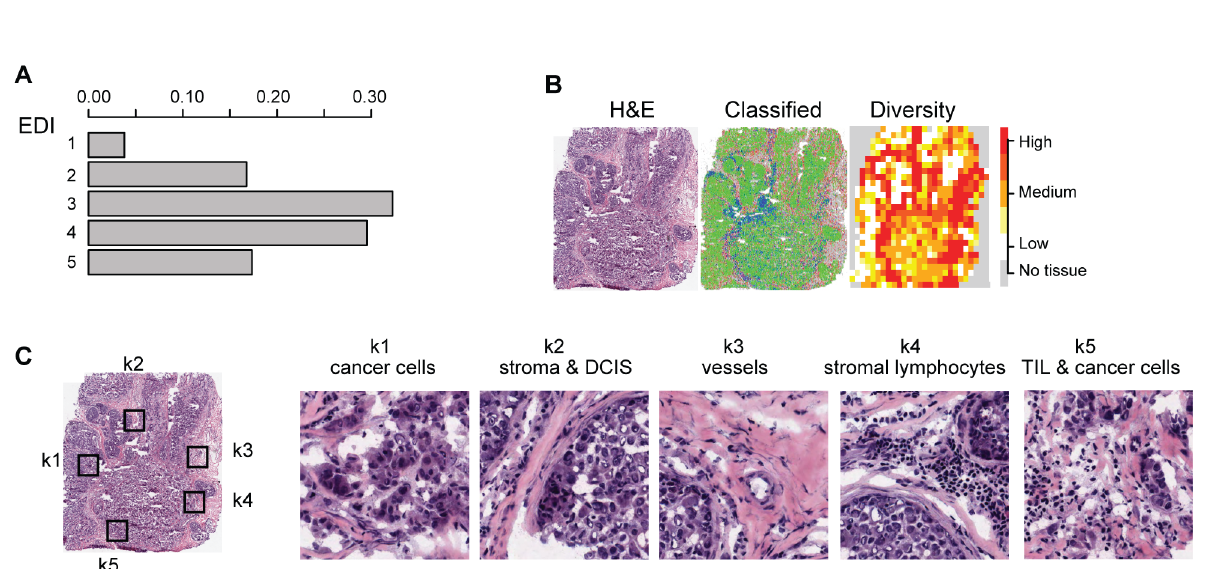
Fig 2. Application of EDI to 1,026 breast tumors from the METABRIC study. (A) The frequencies of EDI scores in breast tumors. (B) H&E staining, distribution of classified cells (green: cancer; blue: lymphocyte; red: stromal cells), and the heatmap of regional diversity scores for a tumor with the highest EDI score (EDI = 5). (C) Representative regions from each of the clusters k1 – k5 are shown in a tumor with EDI = 5, with cluster k1 having the lowest diversity score and k5 the highest. By mapping regional clusters to the H&E image, we can begin to interpret these clusters with different cell diversity. We observed predominantly cancer cells in k1, increasingly more stromal cells and ductal in situ carcinoma cells (DCIS) in k2, and a vessel in k3. Cluster k4 features extensive stromal lymphocytes between ductal in situ carcinoma components, while k5 shows tumor-infiltrating lymphocytes (TIL) associated with invasive carcinoma